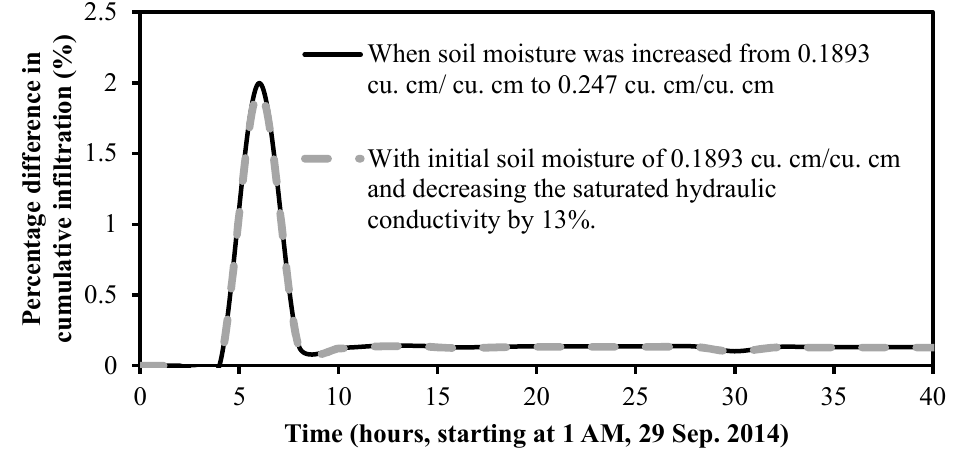
Figure 12. Reproducing similar infiltration amount.